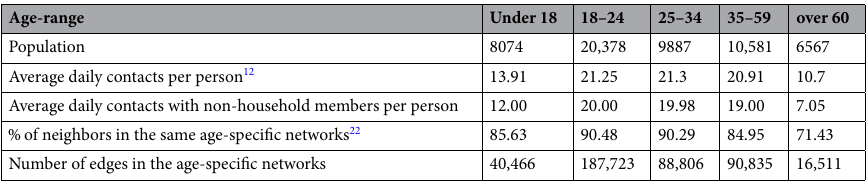
Table 4. Properties of the Age-specific-networks of the Manhattan,